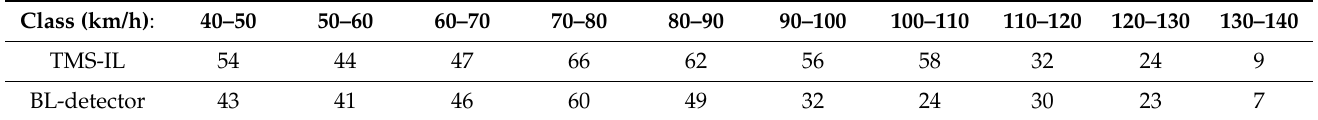
Table 3. Number of detected vehicles per